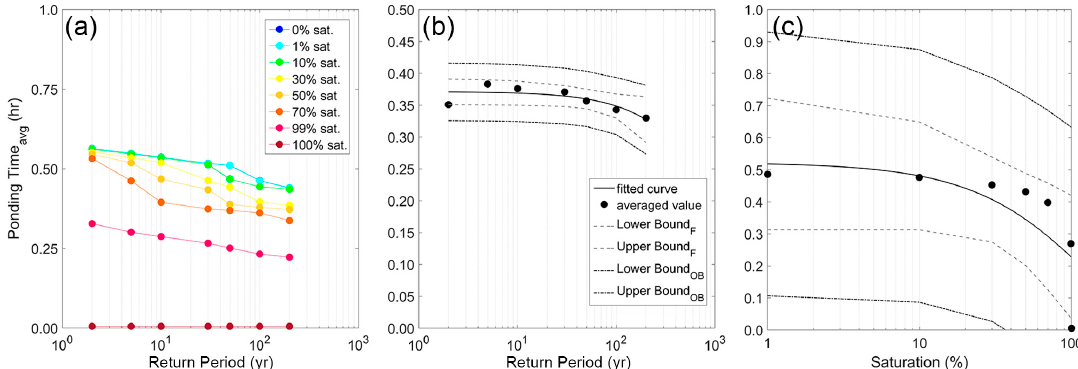
Figure 6. Average ponding time for the considered soil. Ponding time (evaluated considering all hyetograph types) as a function of the Return Period ( a ) averaged for each of the considered antecedent soil moisture condition (0 to 100% saturation), and ( b ) averaged considering all saturation conditions. ( c ) average ponding time considering all hyetograph types and return periods as a function of the antecedent soil moisture condition (saturation). In ( b ) and ( c ) different prediction bounds for Equation (4) are shown: Bound OB describes y n+1 (x), for all x, while Bound F shows the fitted equation for all x. Note that the intervals associated with a new observation (OB) are wider than the fitted function (F) intervals because of the additional uncertainty in predicting a new response value (the curve plus random errors).